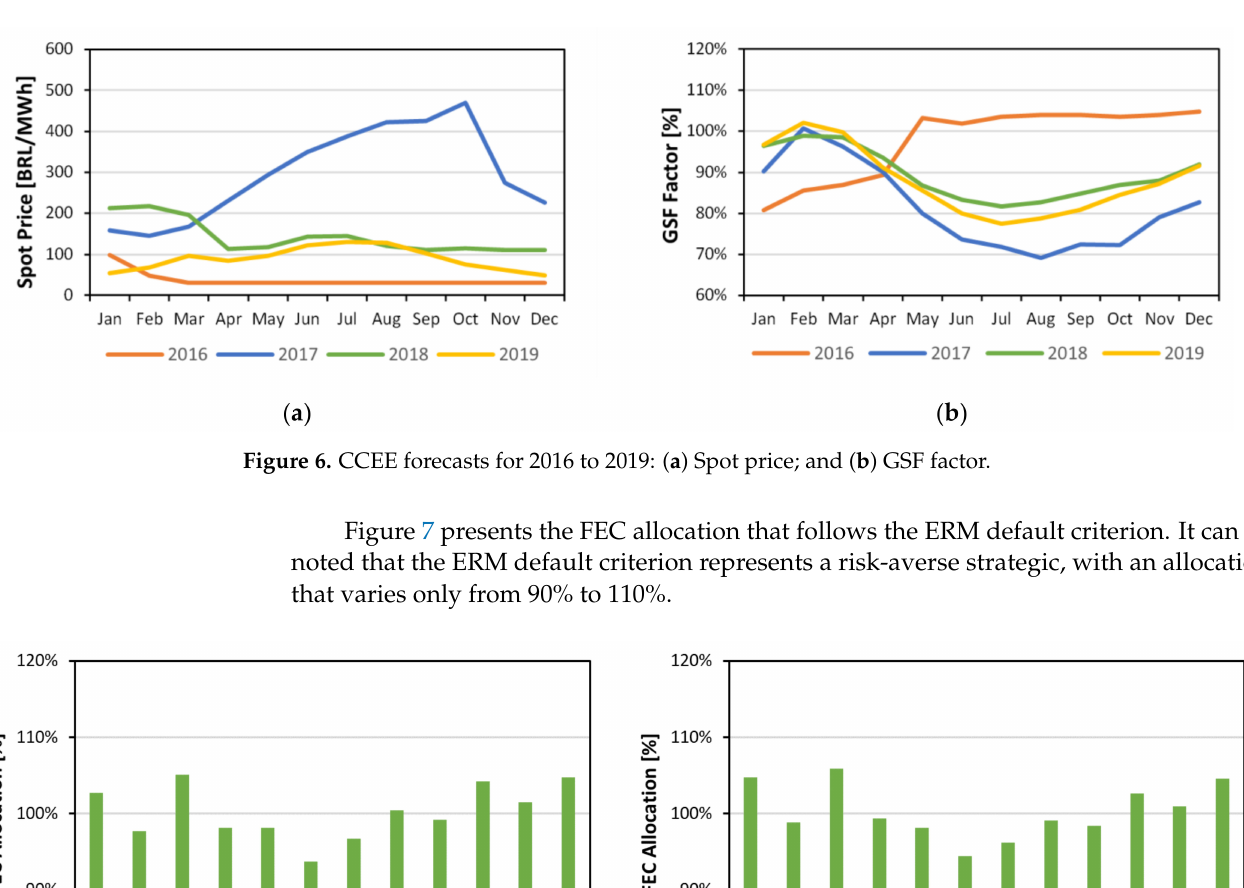
Figure 5. NEWAVE historical simulation forecasts for 2019: ( a ) Spot price; and ( b ) GSF factor. Figure 6 graphs the spot price and the GSF factor forecasts considering the CCEE deterministic scenario [26]. It is important to know that CCEE forecasts started in only 2016.